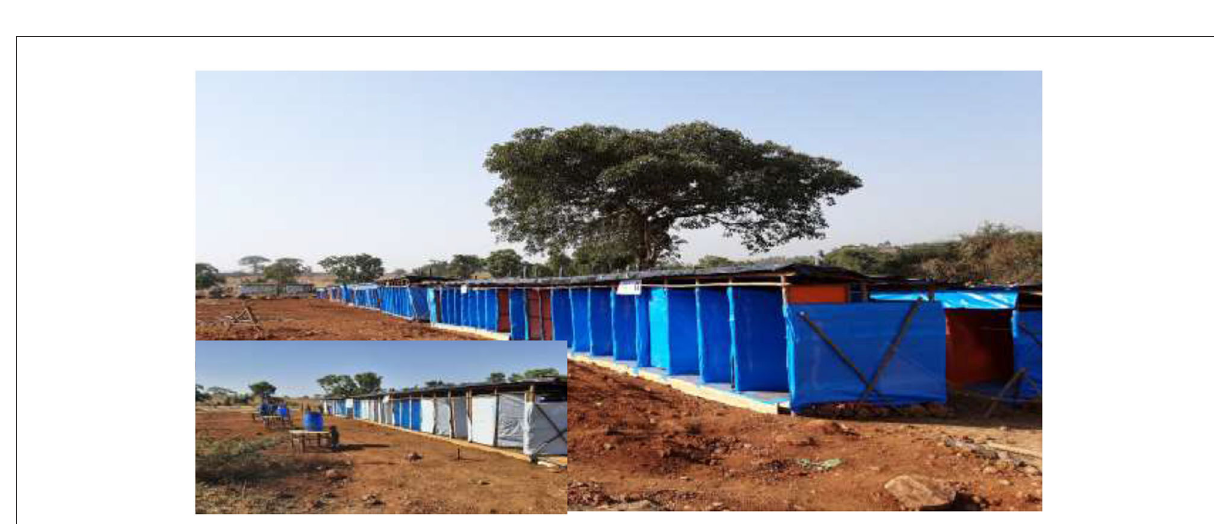
FIGURE4 Trench latrine seats constructed in Ranch collective site, Changi, Ethiopia, November 2020 up to June 2021 ( N =